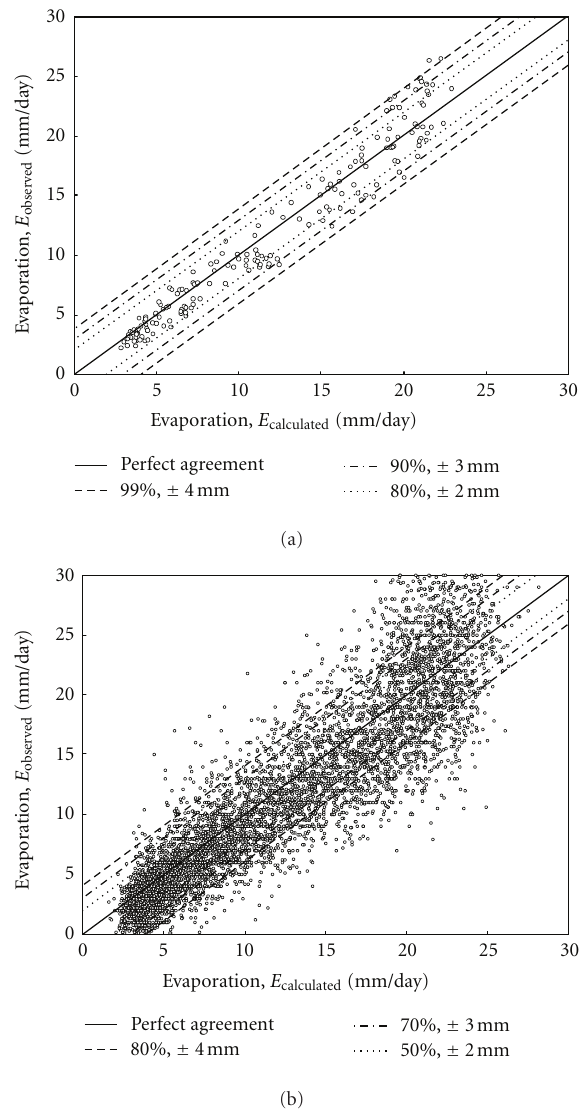
Figure 5: Observed versus calculated evaporation values based on Model 2 for the data of Kuwait from 1993 to 2006 (calibration range). (a) Monthly average data; and (b) daily average data.